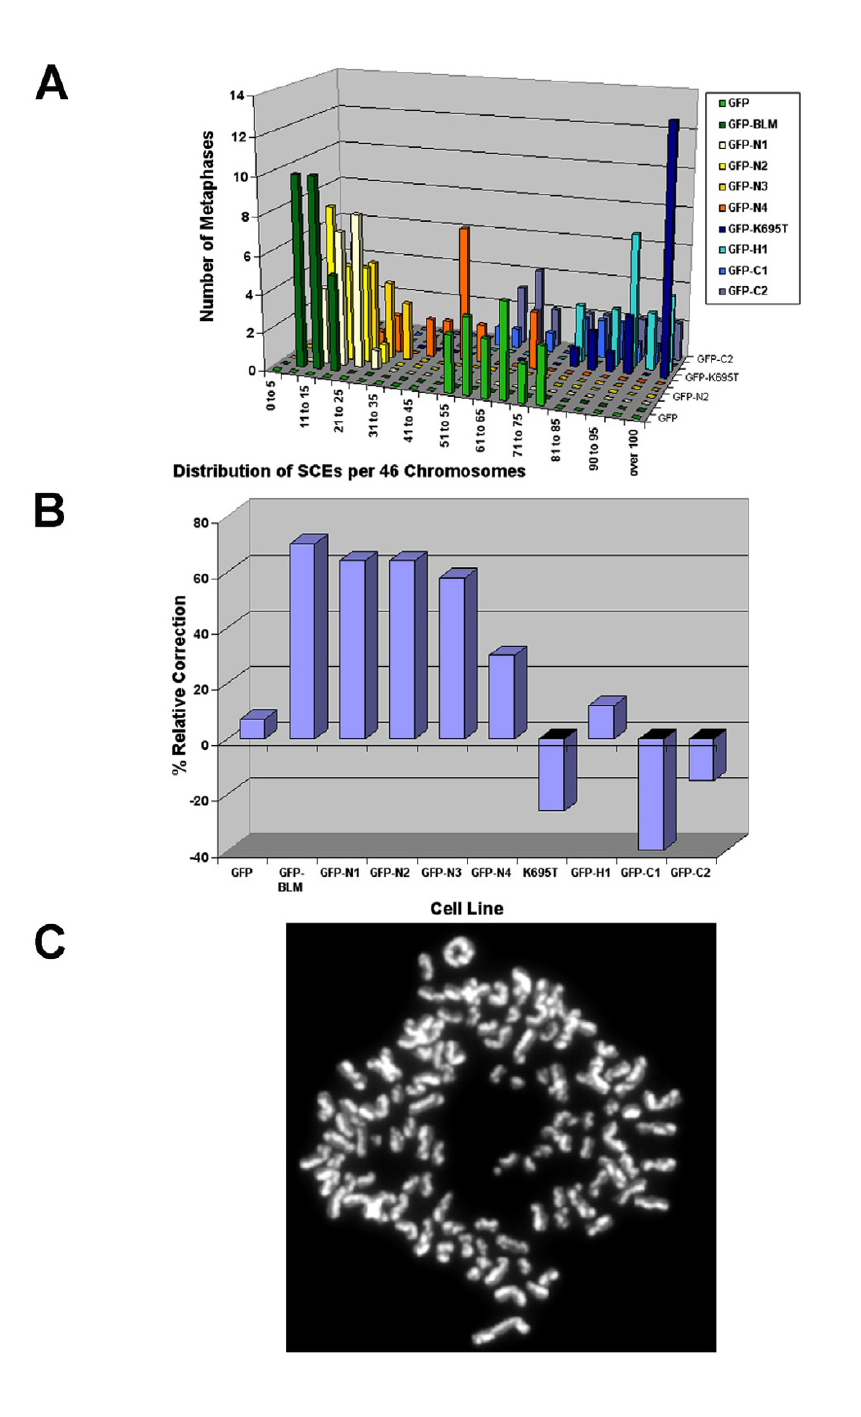
Figure 6 SCE Assay on cell lines with and without inducer. A. Histogram of the distribution of SCEs from induced cell lines. The number of SCEs per 46 chromosomes is plotted vs. the number of cells or metaphases. B. Graphical representation of the rel- ative correction for each GFP-BLM allele (Table 2 & 3). C. Metaphase chromosome spread from an induced cell transfected with GFP- ∆ C1 BLM. A large ring chromosome is shown at the top of the spread. The SCEs are visualized with acridine orange